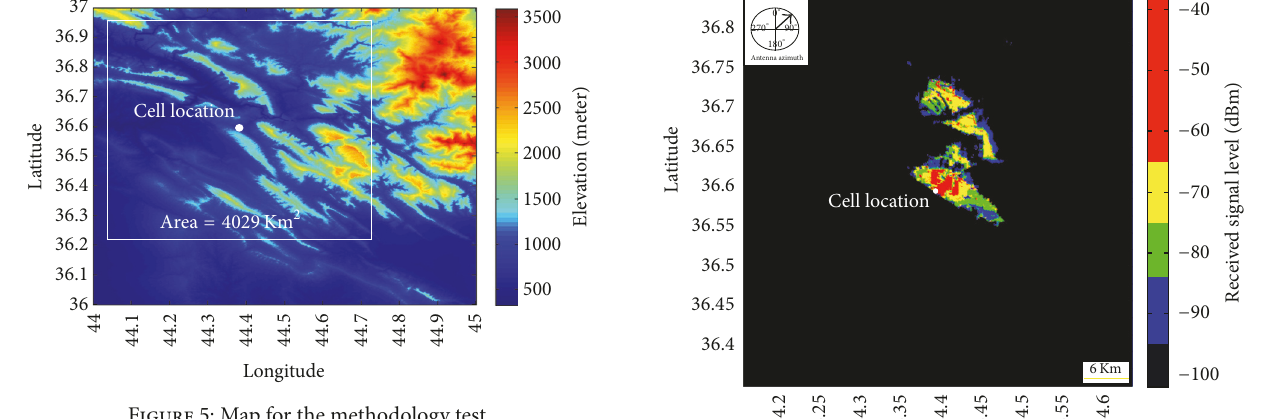
Figure 5: Map for the methodology test.